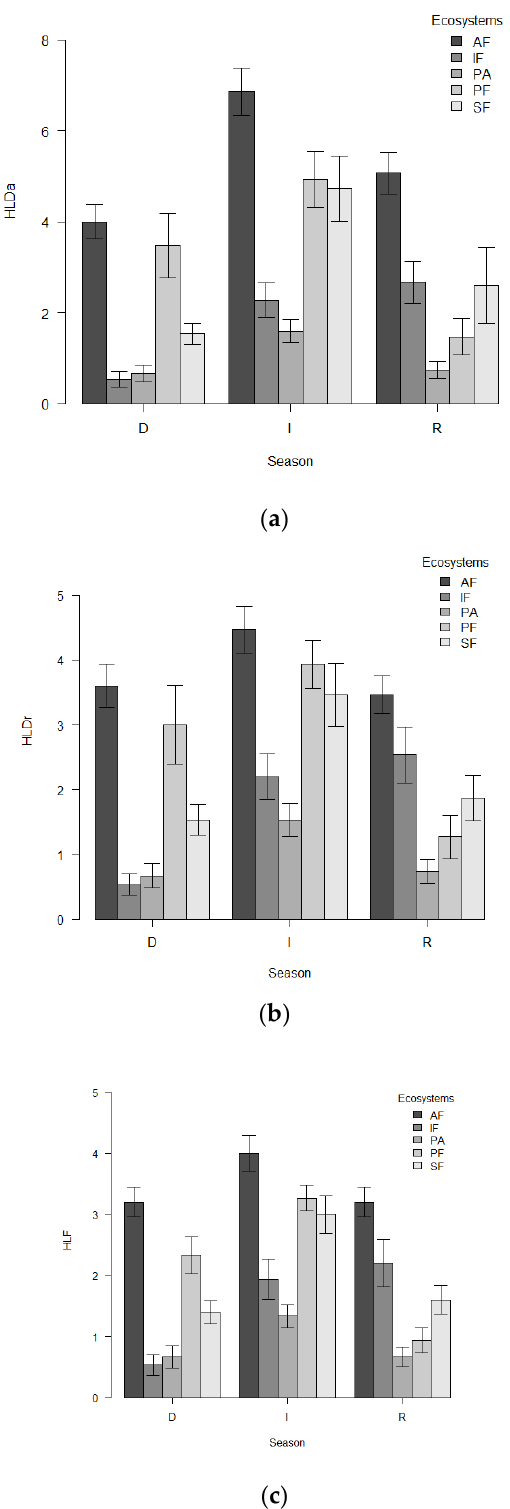
Figure 3. Bar plots expressing the mean differences in high-level diversity abundance (HLDa) ( a ), high-level diversity richness (HLDr) ( b ) and high-level functionality (HLF) ( c ), considering the interactions between the ecosystems and seasons considered. Ecosystems: Primary forest (PF), Secondary forest (SF), Incipient Forest (IF), Agroforestry (AF), and Pasture (PA); Seasons: Dry (D), Intermediate (I), Rainy (R). Standard Error with 95% confidence interval.